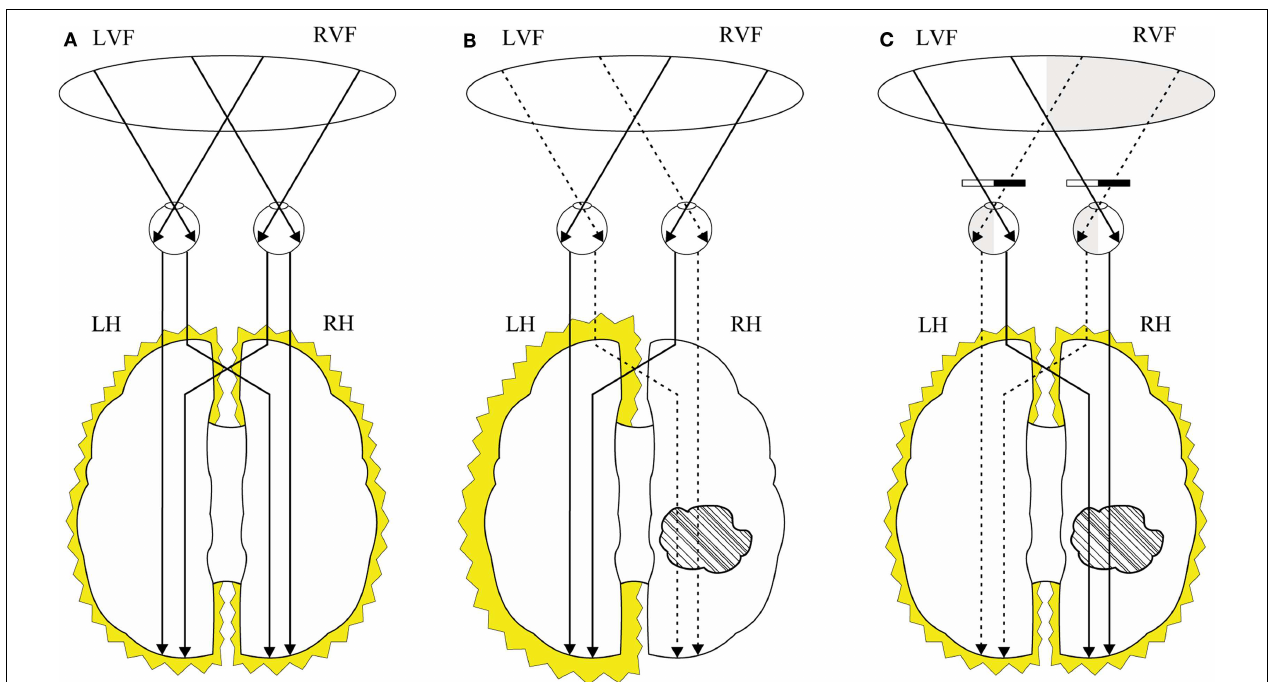
right half-fields in individuals with left hemineglect and right hemisphere stroke stimulates the right hemisphere and reduces the stimulation of the left hemisphere leading to the interhemispheric re-balance . LVF, left visual field; RVF, right visual field; LH, left hemisphere; RH, right